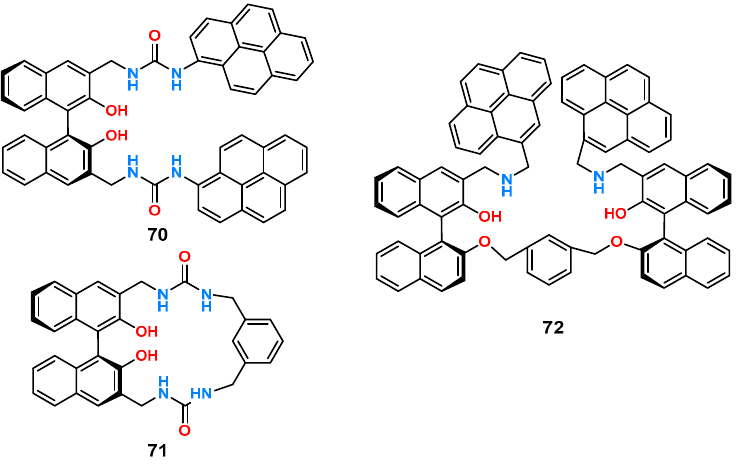
Figure 24. Family of receptors 70 – 72 containing BINOL moiety .